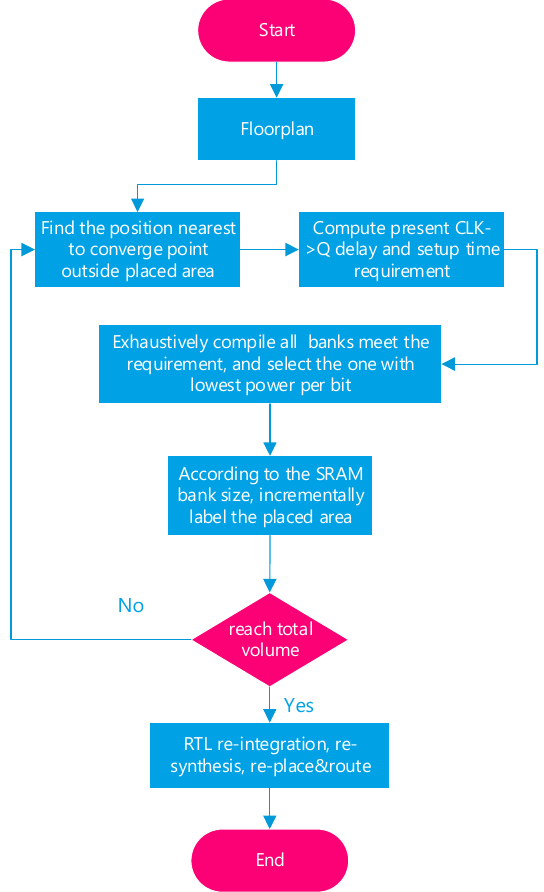
Figure 3. The compilation and placement co-optimization flow.